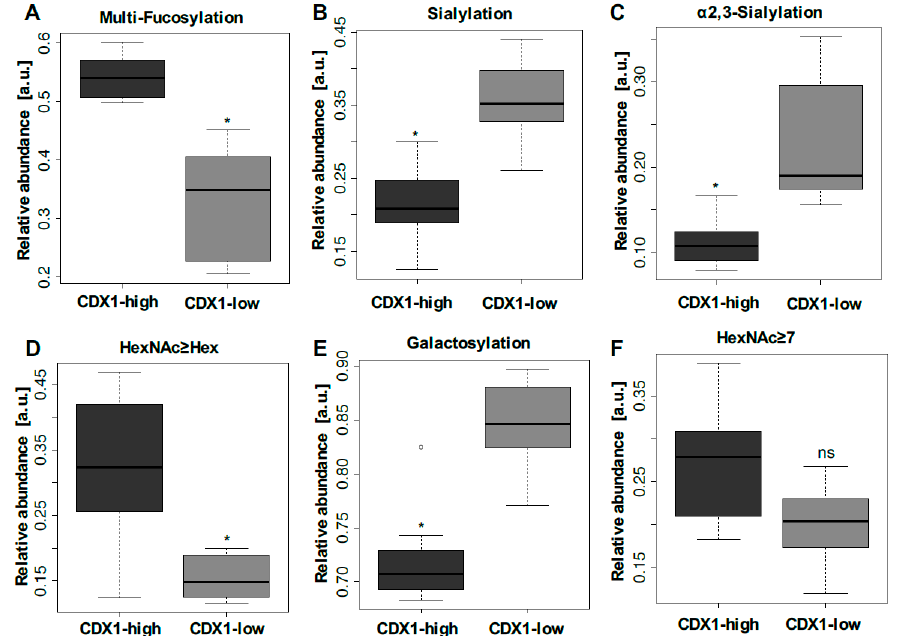
Figure 4. Differentially expressed N -glycan traits. Derived N -glycan traits were calculated to evaluate glycosylation characteristics associated with CDX1 mRNA expression. Differential expressions were observed for ( A ) multi-fucosylation (more than one fucose) indicative for antenna fucosylation, ( B ) overall sialylation ( C ), α 2,3-sialylation, ( D ) N -glycans with more or equal N -acetylhexosamines than hexoses (HexNAc ≥ Hex), ( E ) galactosylation per antenna, and ( F ) N -glycans with seven or more HexNAcs. Differences were evaluated by Mann–Whitney test for derived traits and significances ( p - value < 0.05) after multiple testing corrections are indicated (*), ns = non-significant. Boxplots consistently indicate the median and interquartile range.